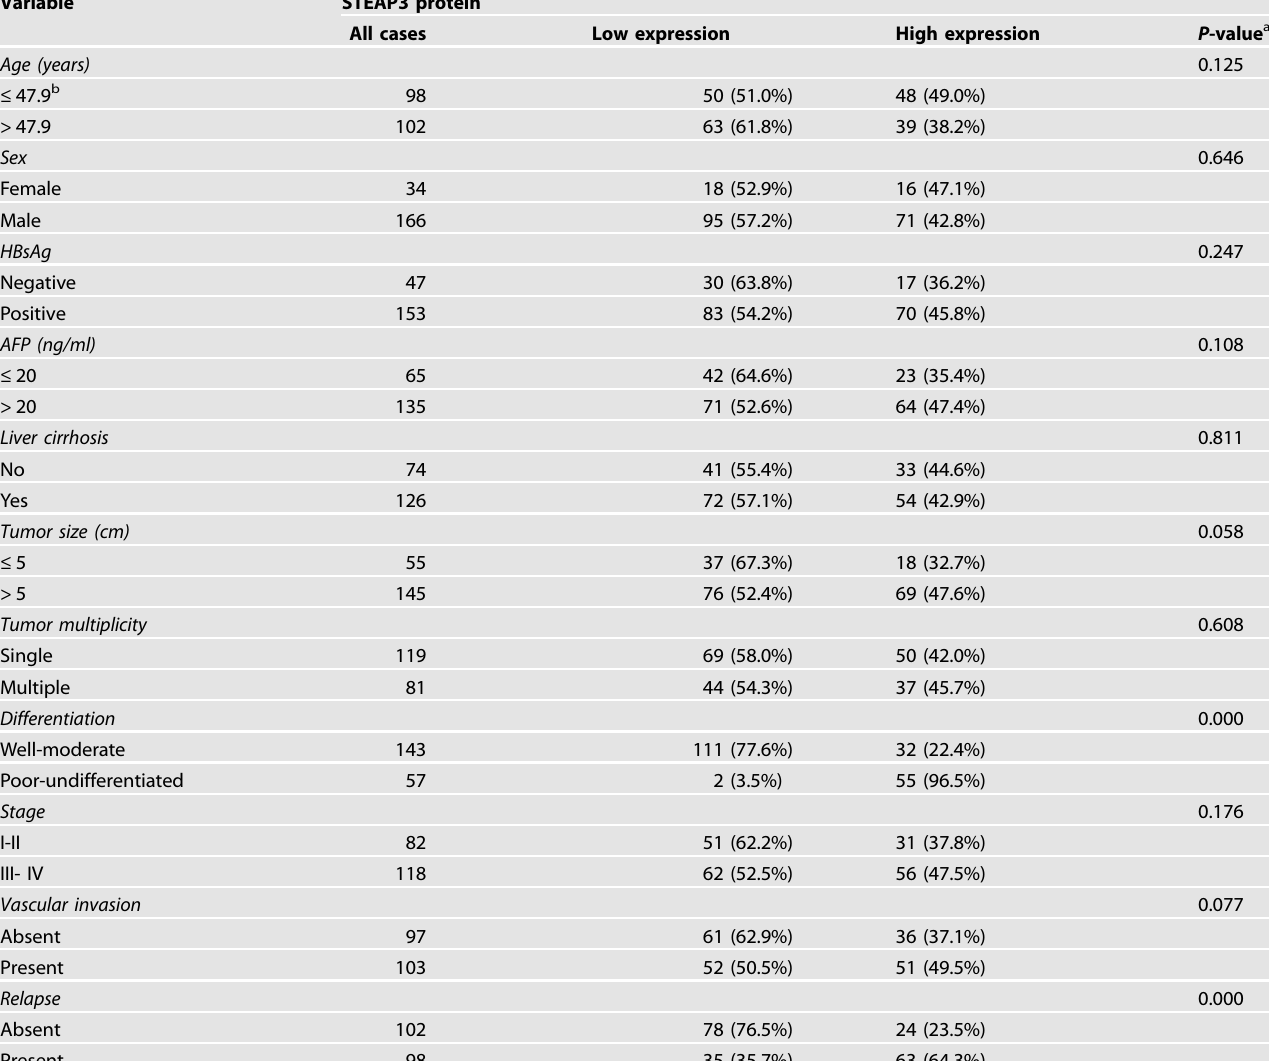
Table 1. Correlation of nuclear expression of STEAP3 with patients ’ clinicopathological features in 200 primary hepatocellular carcinomas. Variable STEAP3